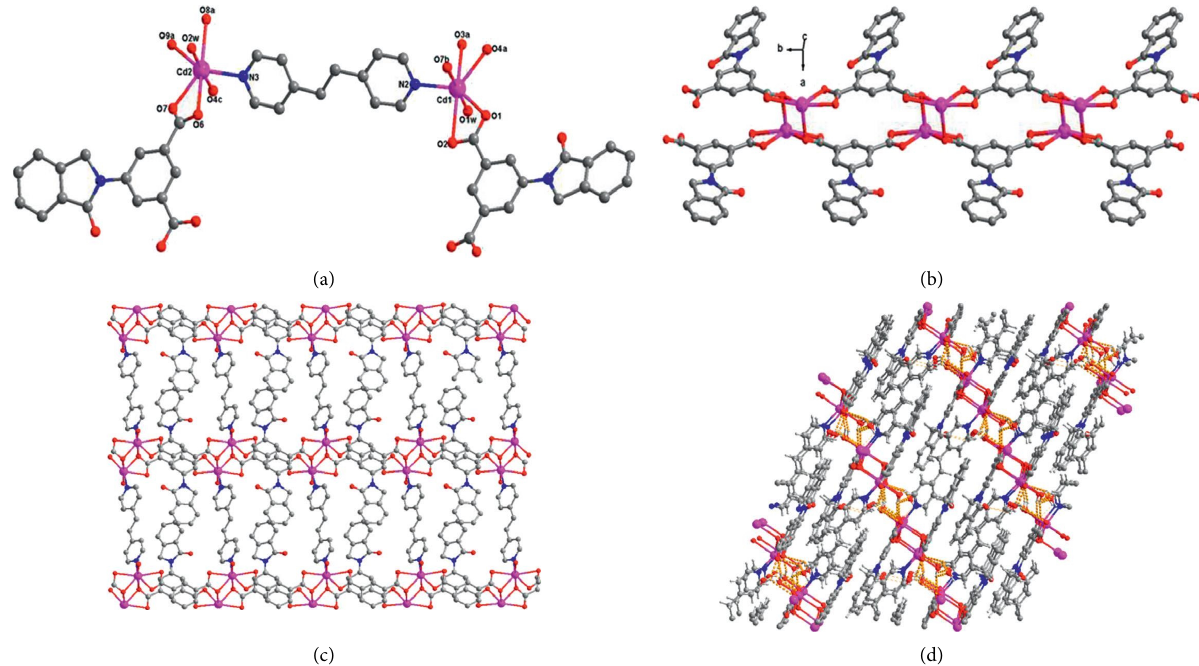
Figure 1: (a) The 1’s coordination surroundings of Cd(II) ions. (b) The 1-dimensional chain architecture was established via the dinuclear subunits [Cd2(COO)2] and IDPA 2 − . (c) The 2-dimensional layered structure of compound 1. (d) The 3D supramolecular structure of compound 1 is linked through intermolecular